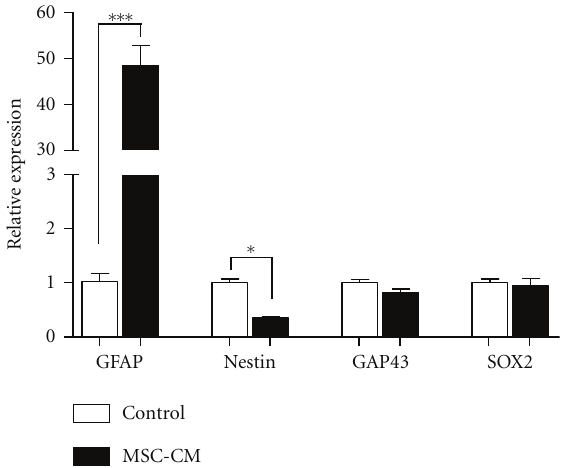
Figure 5: MSC secreted factors upregulate GFAP expression by adult NSC. RNA was extracted from neurospheres cultured in control medium or MSC-CM, and qPCR was performed to evaluate the expression of GFAP, nestin, GAP43, and SOX2. Relative expression was calculated in relation to GAPDH. Data expressed as mean of 2 − ΔΔ Ct ± SEM of triplicates. ∗ P < . 05, ∗∗∗ P < .